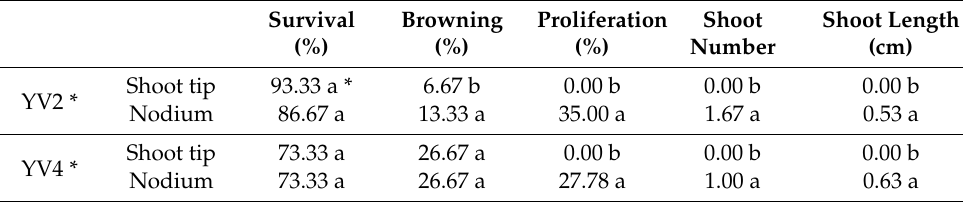
Table 2. Survival, proliferation, and shoot development in the establishment stage of Arbutus